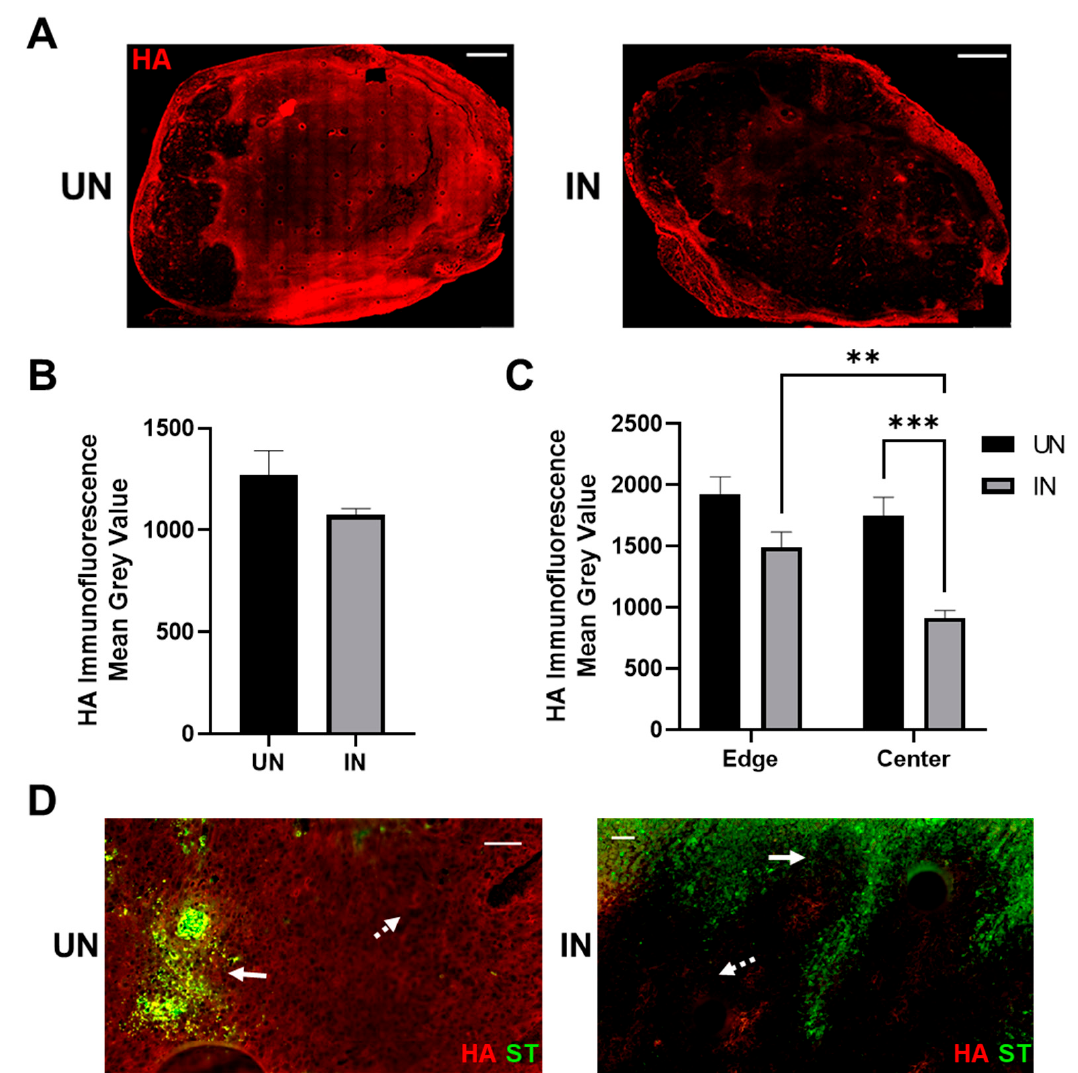
Figure 5. Induction of YS-HAse leads to intratumoral HA depletion in vivo. ( A ) IF staining of YS-HAse-treated tumors for HA. C57BL/6 mice bearing orthotopic EO771 tumors (~100 mm 3 ) were i.v. administered 5 × 10 6 cfu of YS-HAse per day over two days ( n = 5). Forty-eight hours after the first dose, the groups were i.p. administered PBS (UN) or 150 mg L-arabinose (IN) and then euthanized 24 h post-induction. Serial tumor sections were then subjected to IF staining to detect HA. All images are representative of ≥ 3 experiments. Scale bar = 1000 µ m. ( B ) Quantification of the total HA per tumor was performed using ZEN Blue software by dividing the HA channel MGV over the DAPI channel MGV to represent the total tumor area. ( C ) Quantification of the MGV of HA at the tumoral leading edges (~2 mm from the edge) and in the centers of UN and IN tumors was determined using ZEN Blue software. Values represent the average of 5 random areas each on the edges and centers. ** p < 0.01 and *** p < 0.001, two-way ANOVA with Sidak’s multiple comparisons test. ( D ) Overlay of the HA and ST channels on uninduced (UN) and induced (IN) tumors treated with YS-HAse. Solid arrows indicate ST; dashed arrows indicate distal HA. Scale bar = 50 μ m.